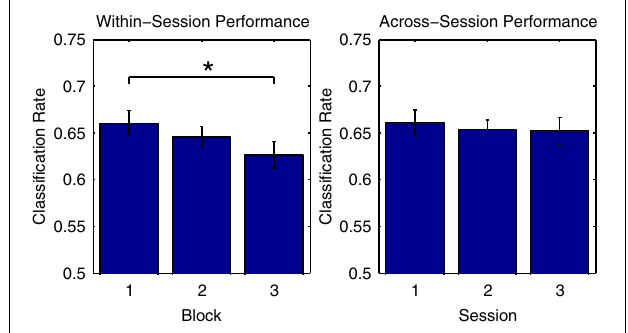
FIGURE 4 | Comparison of preprocessing effects on classification performance across datasets. The two datasets presented in this paper, as well as data collected in Brandmeyer et al. (2013) from 11 native English speakers using English language speech stimuli, were used to evaluate whether the optimal parameters for preprocessing steps observed for Dataset 1 generalized to novel datasets and types of stimuli. Performance was compared when using the original filter (1–25Hz band-pass) and sampling rates (256Hz for Datasets 1 & 2, 128Hz for Brandmeyer et al., 2013), and when using the optimal filter (0.5–13Hz) and sample rate (32 Hz). Significant improvements in mean performance were observed for all three datasets. The significance of paired-sample t -test comparisons is indicated using asterisks: ∗ p < 0 . 05, ∗∗ p < 0 . 01, ∗∗∗ p < 0 . 001. Table 2 | Summary of optimized preprocessing parameters.